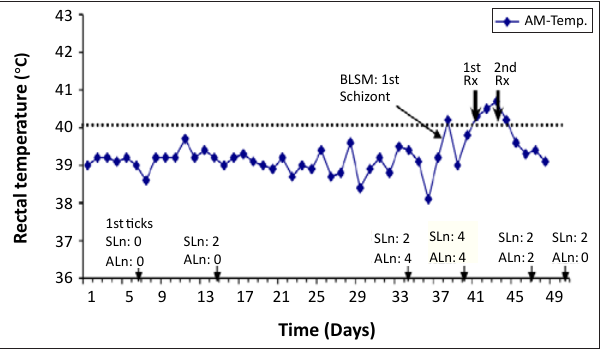
FIGURE 5: Animal 242: Blood smear findings, lymph node findings and day of treatment in relation to rectal temperature over time.